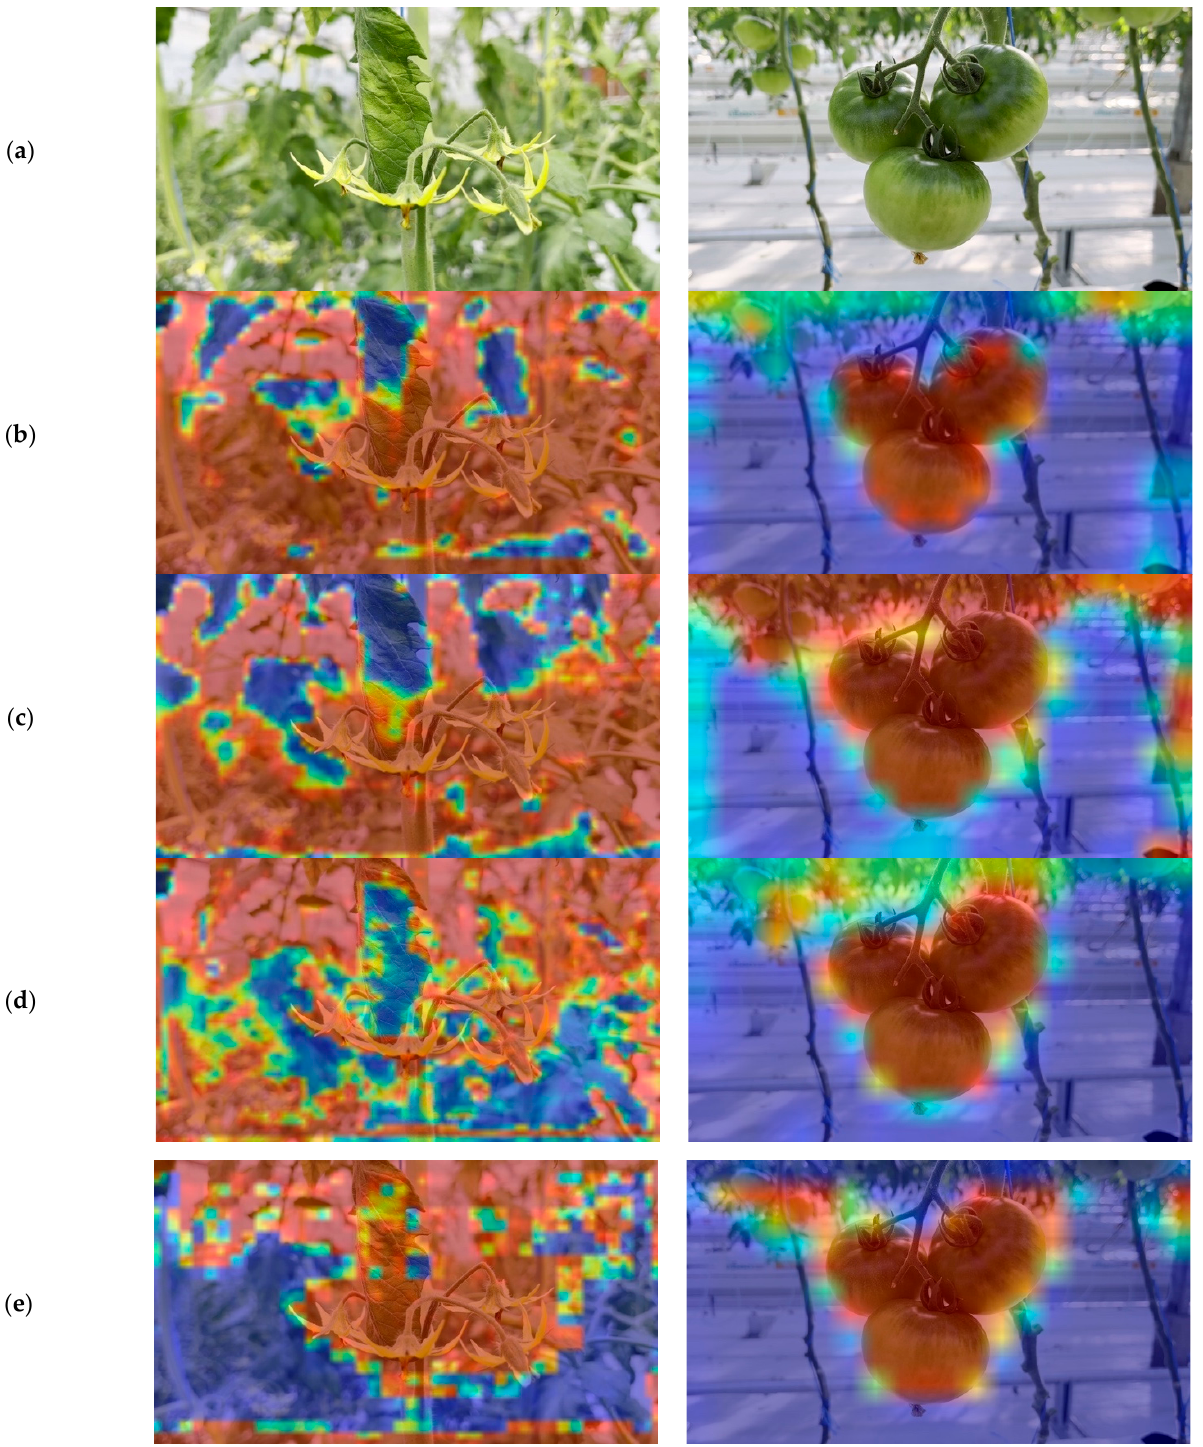
Figure 15. ( a ) Input images; ( b ) the heatmap of YOLOv5 s; ( c ) the heatmap of YOLOv5 m; ( d ) the heatmap of YOLOv5 l. ( e ) The heatmap of YOLO-deepsort.